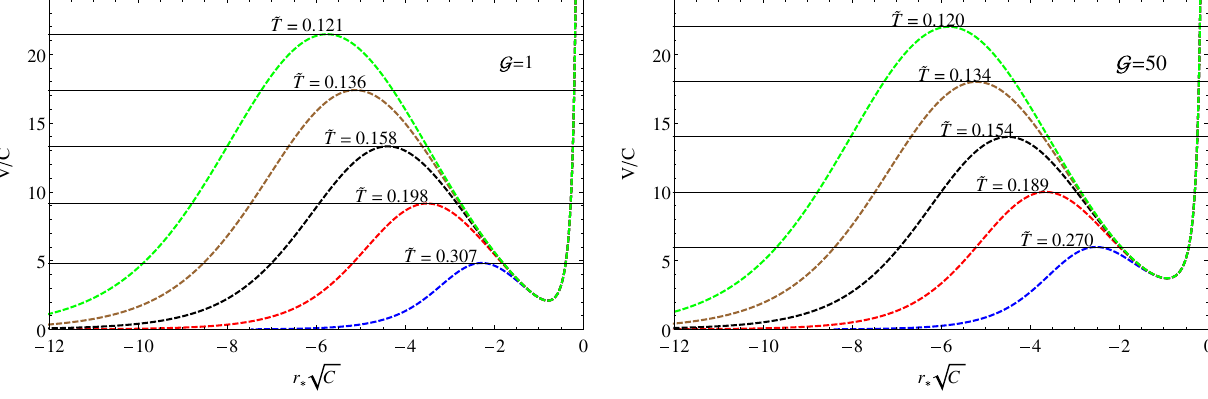
Fig. 5 Potential with zero wavenumber for low temperatures for G = 1 (left panel) and G = 50 (right panel). It is evident how the potential is deformed with the